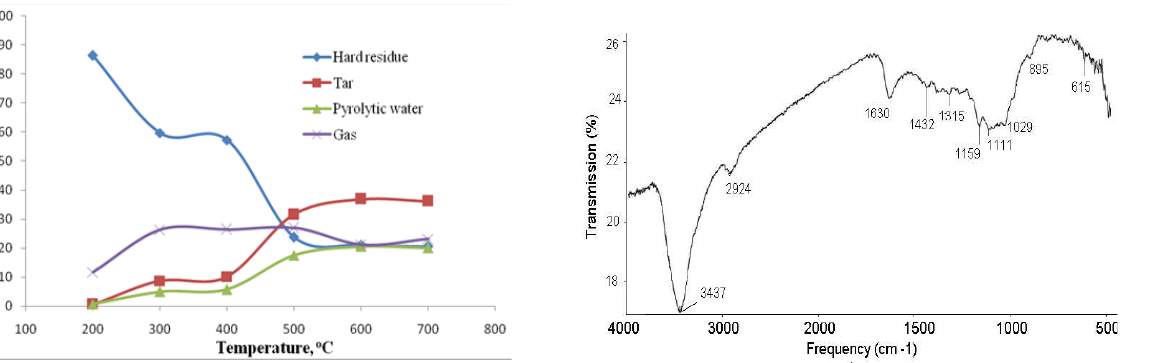
Fig. 1. The yields of pyrolysis products of casein at different temperatures.